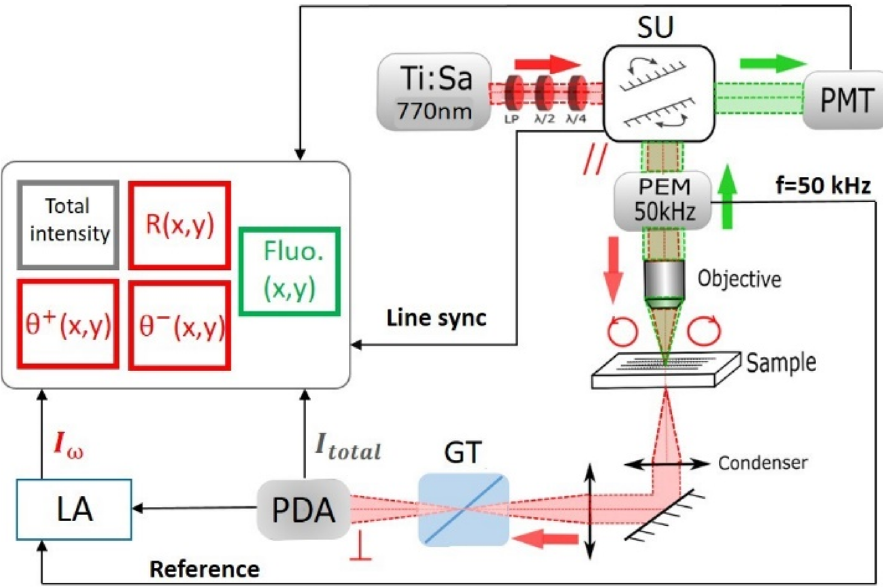
Figure 1. Block diagram of the bimodal scanning microscopy setup; Ti:Sa: Titanium–Sapphire coherent laser source tuned at 770 nm. SU scanning unit, PEM photoelastic modulator at 50 kHz resonant frequency, GT Glan–Taylor prism, PDA photodiode, LA lock-in amplifier, PMT photon multiplier tube. The red and green colors indicate optical path correspond to the transmitted polarimetric and to the reflected fluorescence path, respectively. θ + , θ − representing positive and negative parts of phase of the demodulated